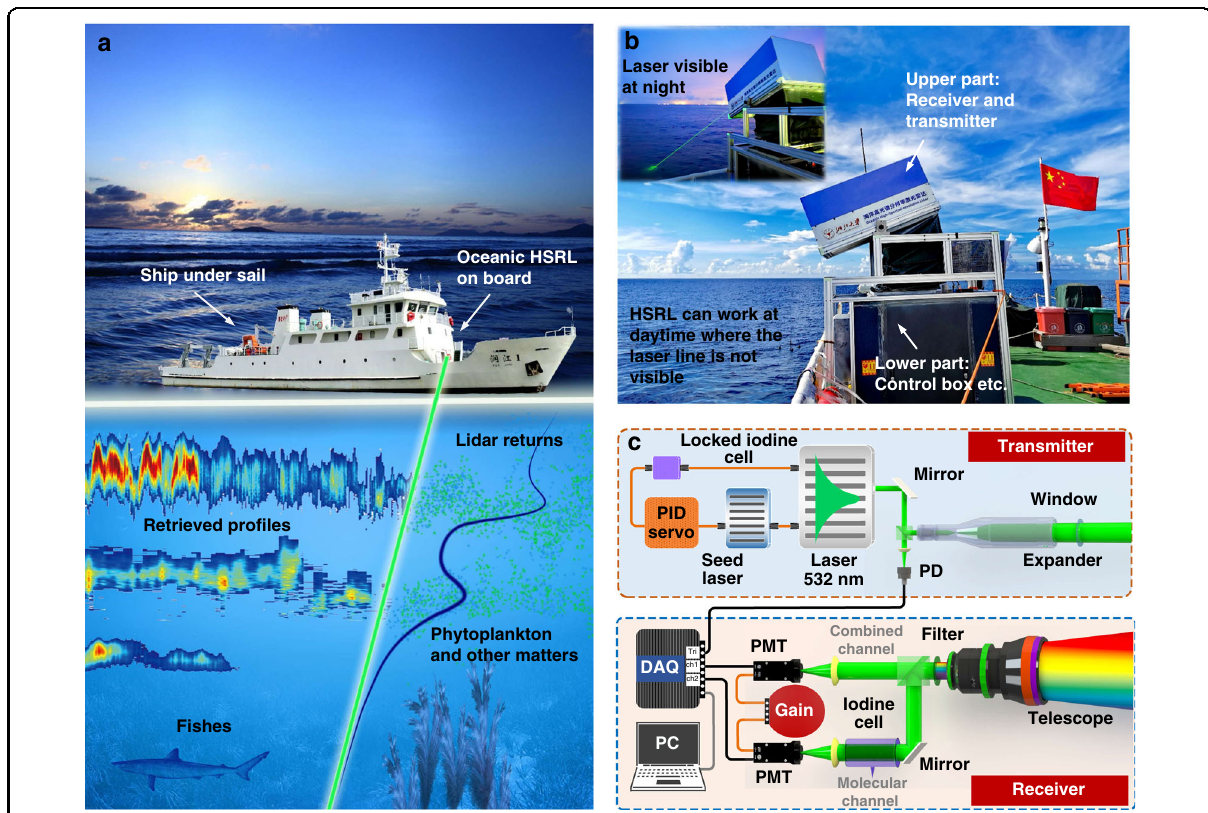
Fig. 1 Principle of the shipborne oceanic HSRL. a Concept of the shipborne HSRL pro fi ling seawater optical properties. b HSRL can work at both day- and night-time. c Schematic diagram of the HSRL system with the iodine absorption cell